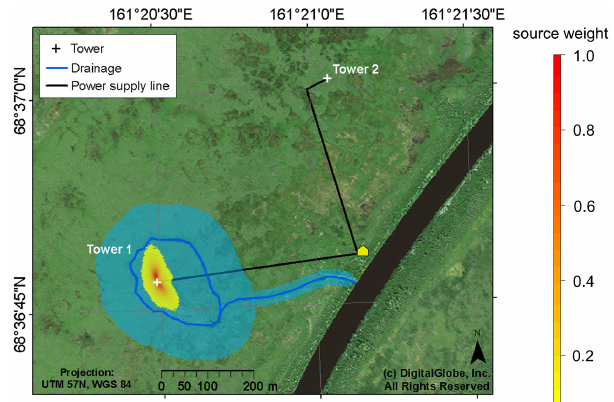
Figure 1. Overview of observational setup and site facilities on a wet tussock tundra near Chersky. The circular drainage ditch and drainage channel (blue lines) were installed in 2004 and are still in place today, altering the water table depth (blue shaded area out- line the approximate area affected by the drainage). The image also depicts the towers (white crosses), power lines (black lines), and generator housing (yellow hut). The red-yellow colored area around Tower 1 indicates the weighted source function of footprints aver- aged over all stability classes from 15 May to 14 September 2014.